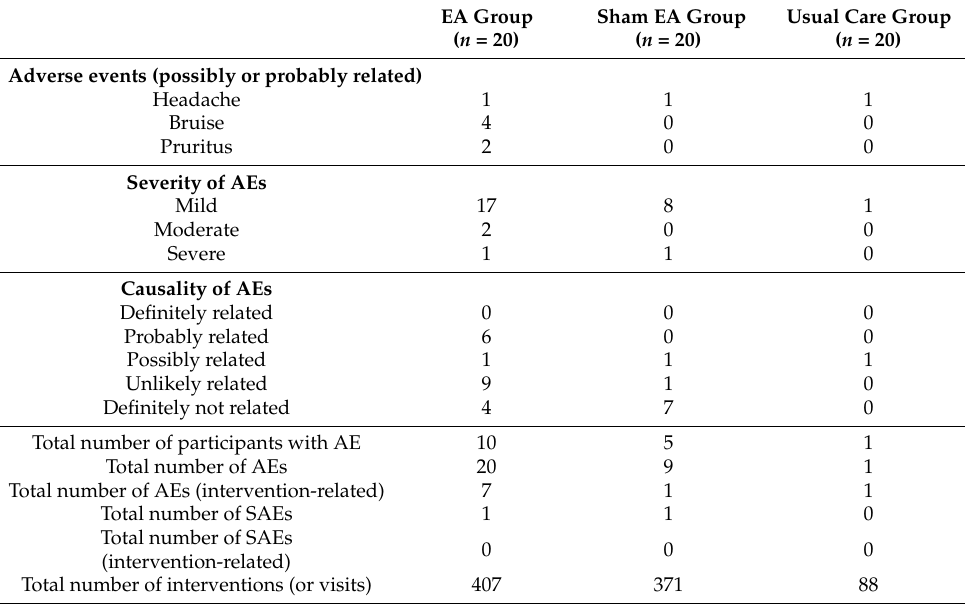
Table 5. Adverse events (all causalities) reported during the